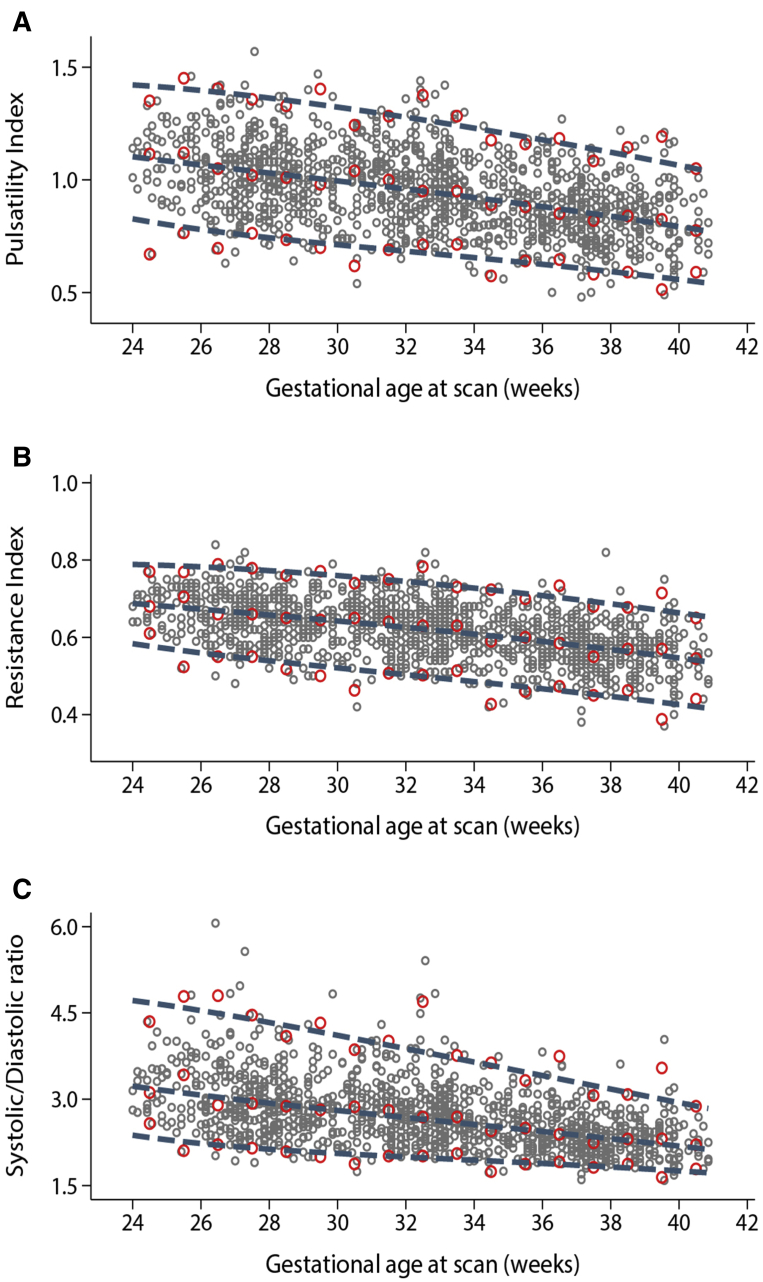
Smoothed 3rd, 50th, and 97th centile curves of umbilical artery Doppler indicesFitted centiles according to gestational age in weeks are presented as blue dashed lines for (A) pulsatility index, (B) resistance index, and (C) systolic/diastolic ratio. Red circles show empirical 3rd, 50th, and 97th centiles for each completed week of gestation; gray circles show individual observations.Drukker et al. International gestational age-specific centiles for umbilical artery Doppler indices: a longitudinal prospective cohort study of the INTERGROWTH-21st Project. Am J Obstet Gynecol 2020.